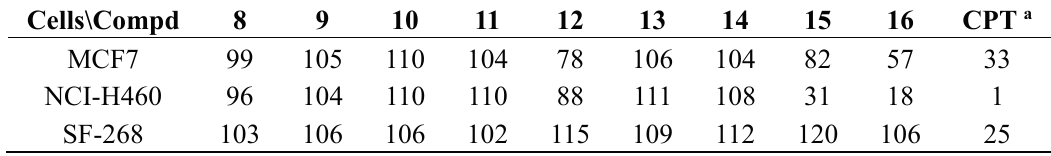
Table 2. Cytotoxicity (% survival rate) of benzo[ f ]indole-4,9-dione derivatives at 4 μ g/mL.